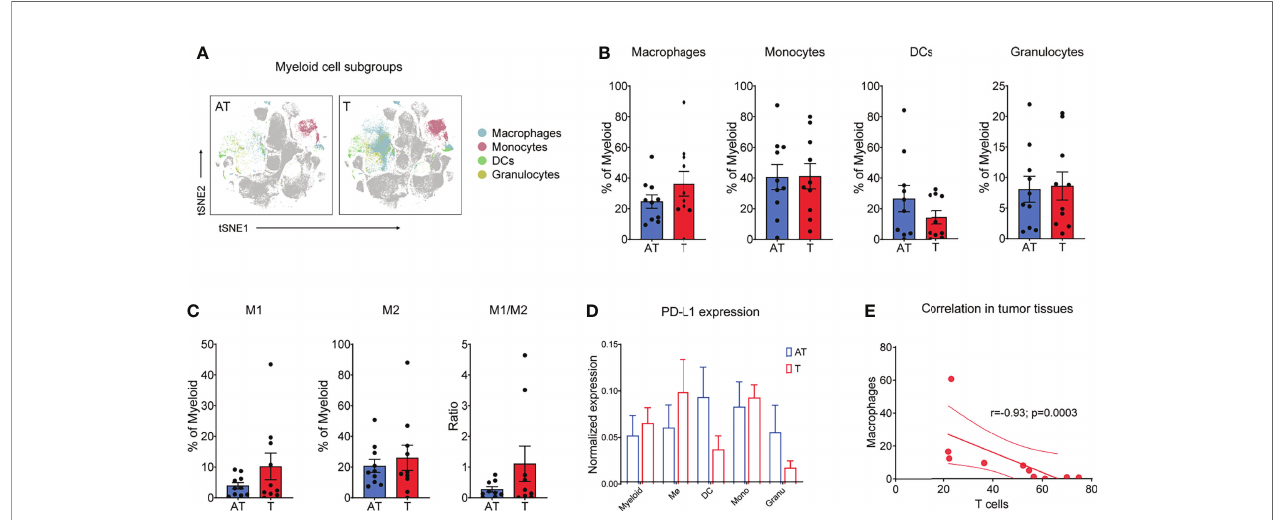
FIGURE 3 | Myeloid cells show a distinct phenotype in a GC-immune microenvironment. (A) tSNE plots showing the distribution/localization of the myeloid cell subgroups in adjacent tissues and tumor tissues. (B) Frequency of macrophages, monocytes, dendric cells (DCs), and granulocytes for each patient based on summation of Phenograph clusters. (C) Frequency of M1 and M2 types of macrophages and M1/M2 ratio for each patient based on summation of Phenograph clusters. (D) Expression level of PD-L1 on different T-cell subgroups (left) and tSNE maps of relative expression of the PD-L1 for myeloid cell subgroups in GC samples of adjacent tissues and tumor tissues. (E) Correlation between T cells and macrophages in all tumor tissues. Spearman ’ s correlation r and p values are shown. Bar plots show mean ± SEM.